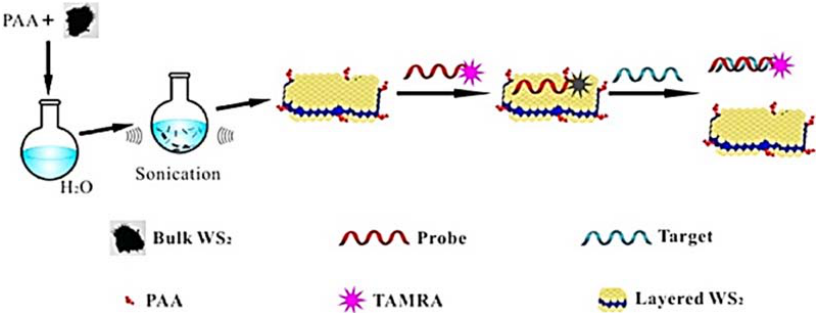
Figure 10. Schematic Illustration of fluorescence sensing of nucleic acid and protein with layered WS 2 nanosheet as the quencher. Adapted with permission from [64]. PAA is polyacrylic acid; TAMRA is the TAMRA dyelabeled ssDNA probe P1: 5’-TAMRA-AGTCAGTGTGGAAAATCTCTAGC-3. Copyright 2014. American Chemical Society.